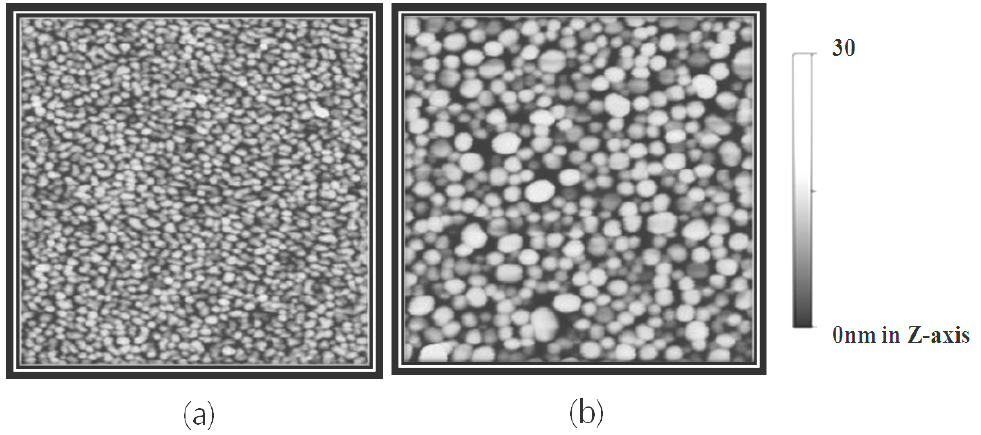
Figure 2. 2-D AFM images of (a) non-annealed gold NI film and (b) annealed gold NI film. The scan ranges are 1 × 1  m 2